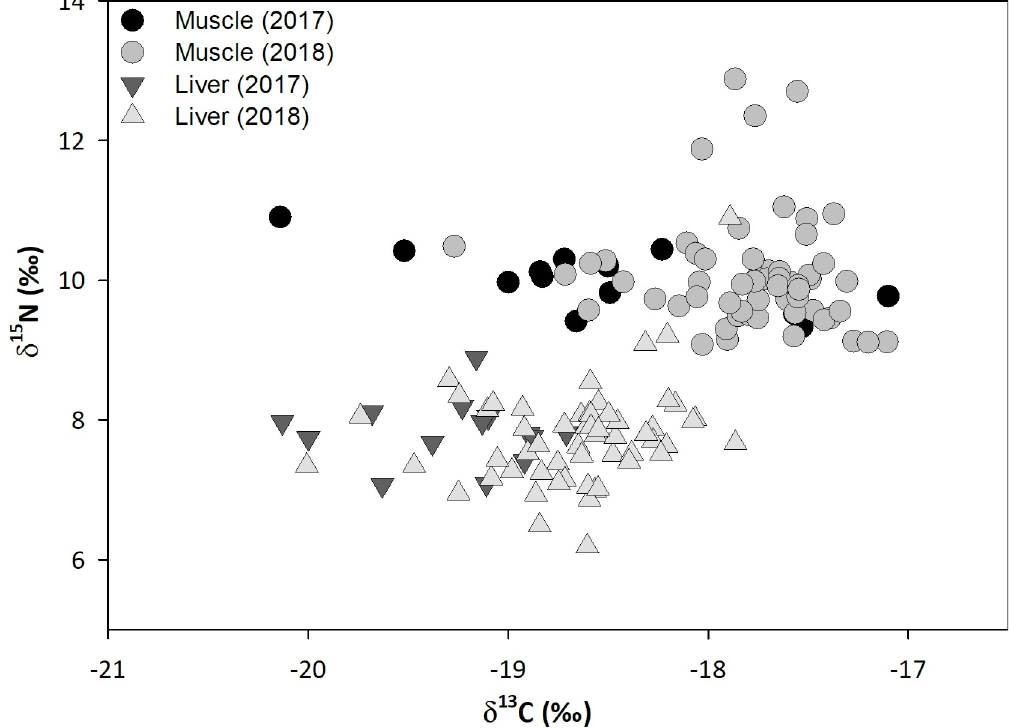
Fig 2. Scatterplot of bulk carbon vs. nitrogen isotope ratios. Isotopic composition of muscle (WM) and liver (LVR) tissues of 72 yellowfin tuna ( T . albacares ) caught in the southern (2017) and southern-central (2018) Gulf of Mexico.